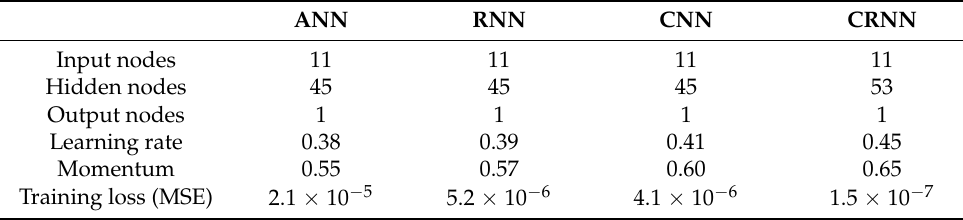
Table 3. Training and validation losses in terms of the mean square error